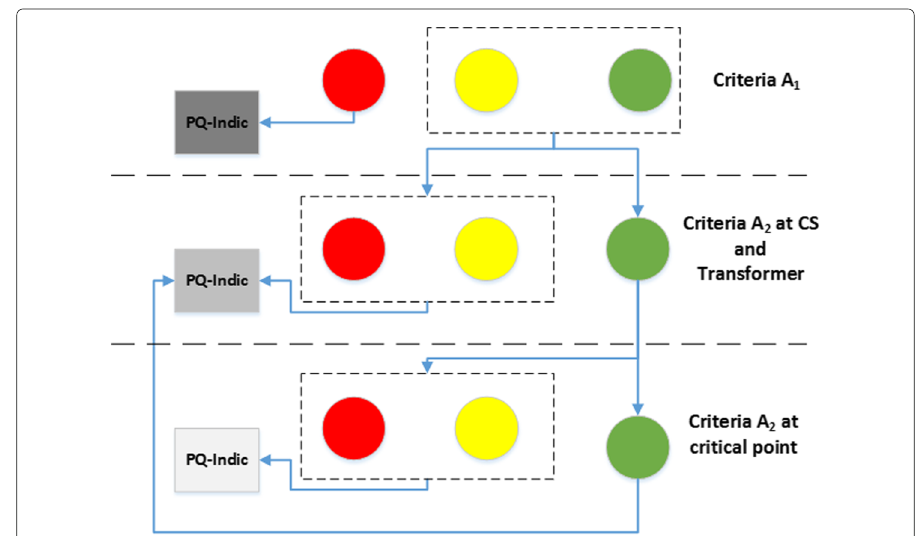
Fig. 4 Hierarchical decision logic of the PQ-Indicator based on the traffic light model